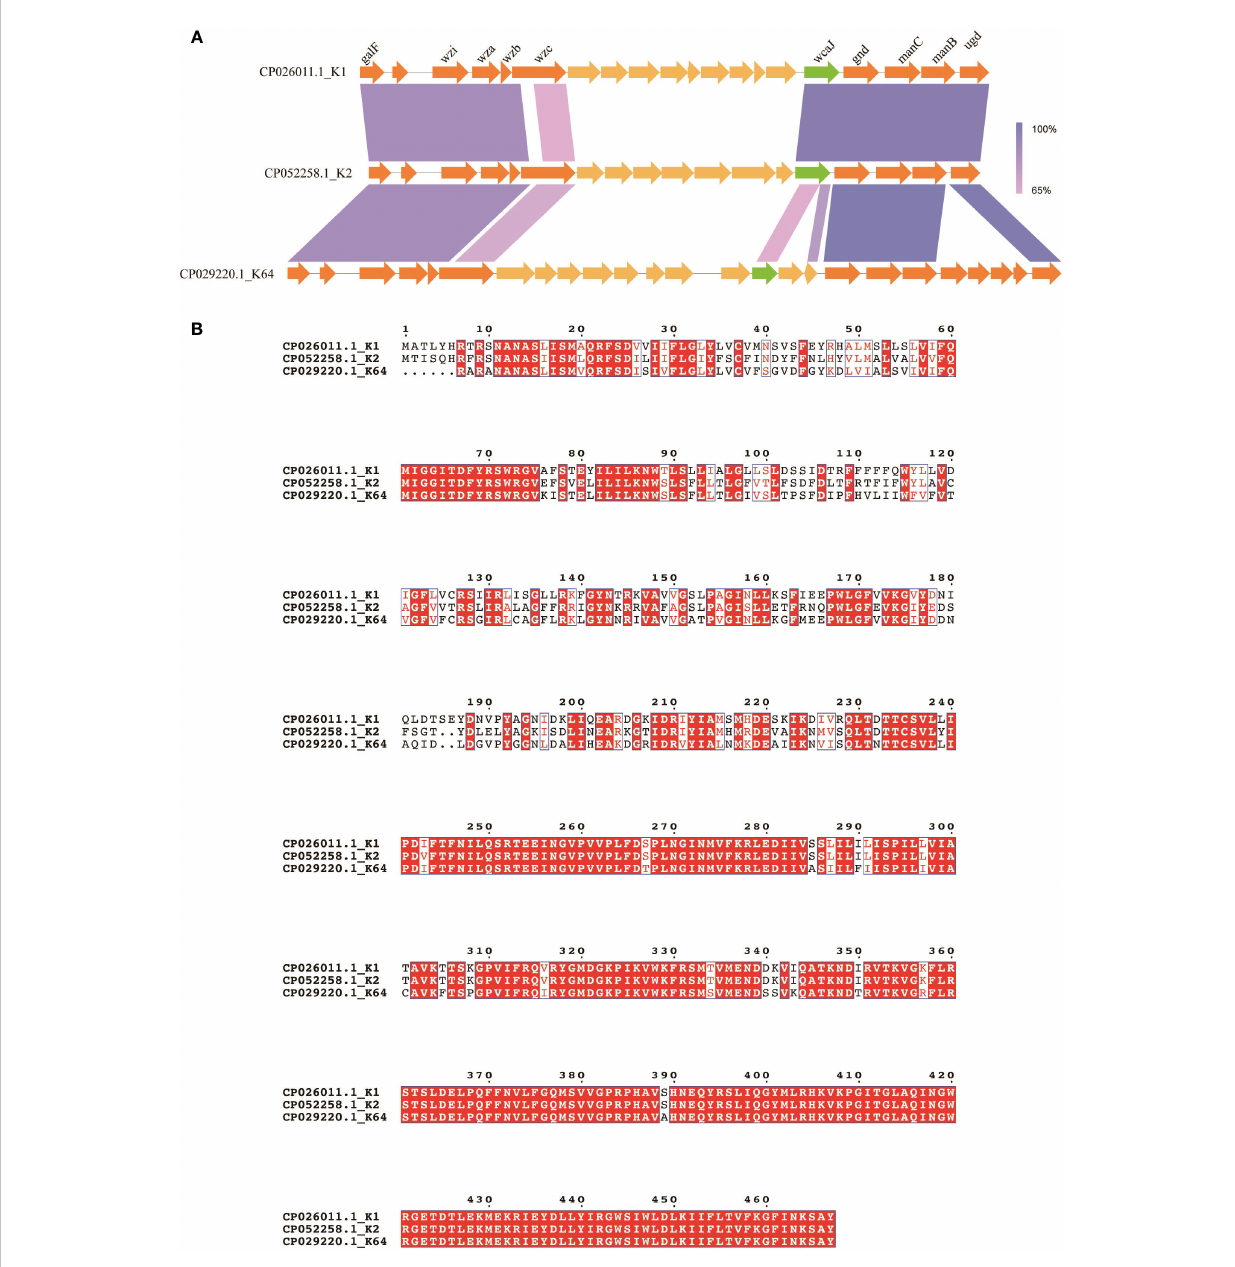
FIGURE 4 Comparison of wcaJ sequences among K1, K2, and K64 serotypes. (A) The genetic differences between the cps clusters of the K1, K2, and K64 serotypes. (B) The WcaJ protein sequences in the K1, K2, and K64 serotypes. Alignment was performed using the MUSCLE sequence alignment